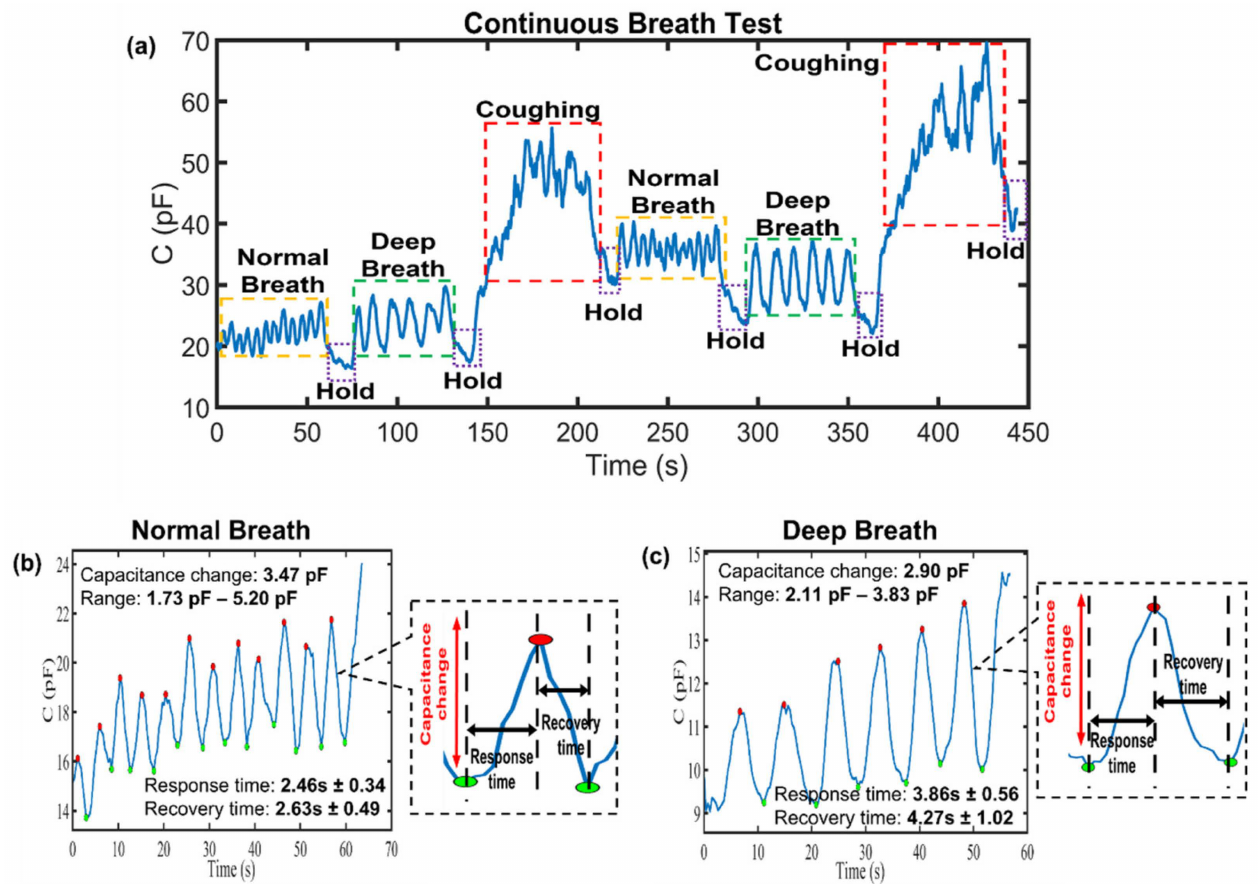
Figure 6. ( a ) Continuous breath monitoring tests were performed under three conditions: normal breathing (12 breaths), deep breathing (7 breaths), and coughing (40 coughs) at every 1 minute, and the holding of breath for 10 s before the next one. The response time and recovery time of ( b ) a normal breathing and ( c ) deep